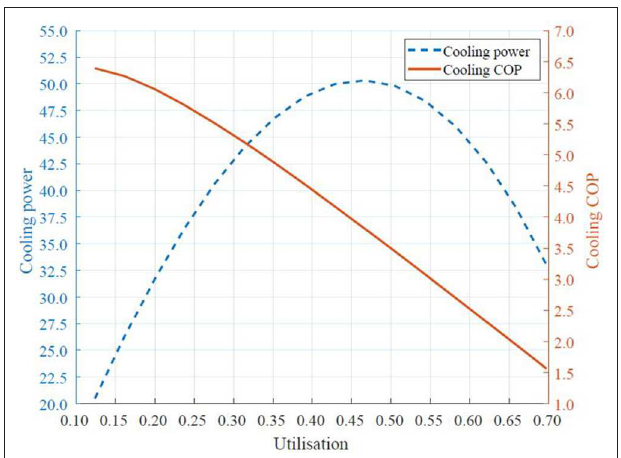
FIGURE 7 | Cooling power (left axis) and cooling COP (right axis) as a function of utilization in cassette 1 with the cylindrical micro-channel matrix at ε = 0.36, 2Hz and D h =